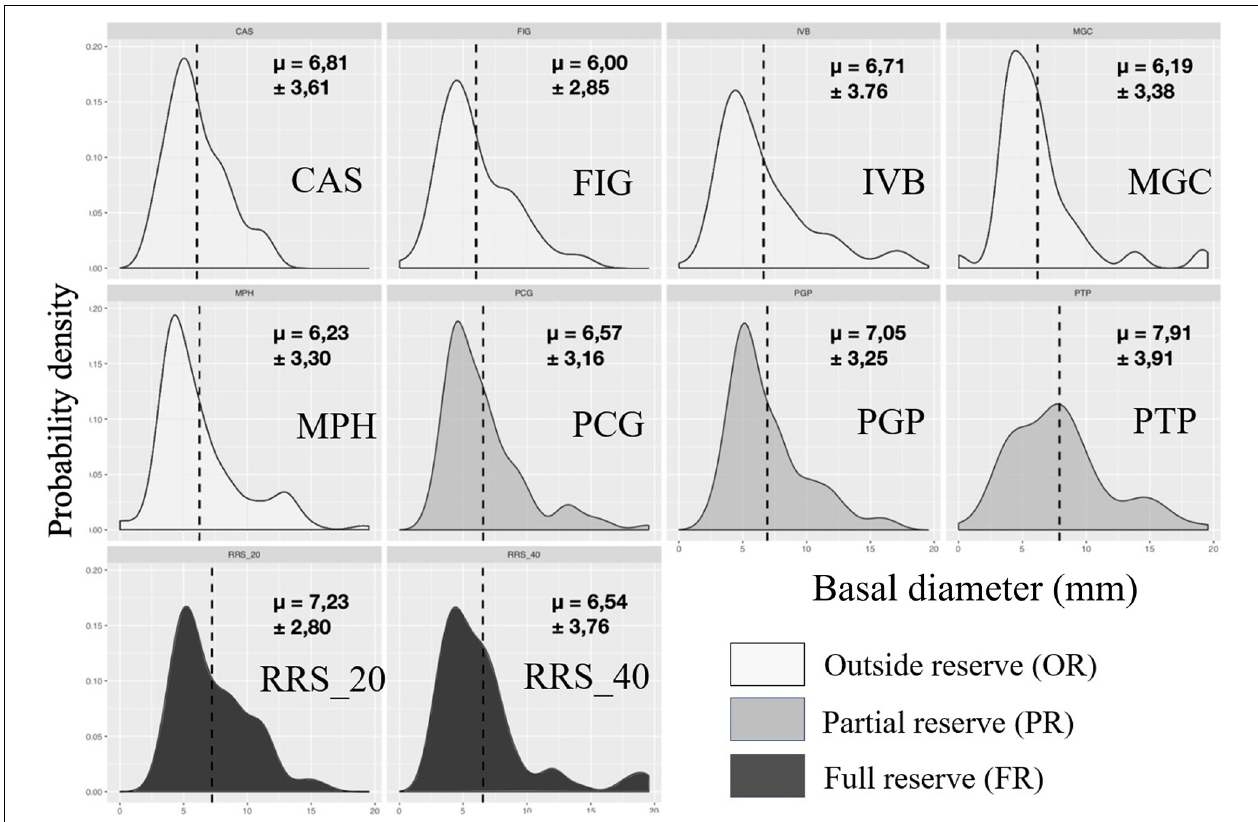
FIGURE 6 | Calanques national park: representation of probability density functions by population of each site for basal diameter (mm) in 2020. The values indicated correspond to the means followed by the standard deviations. In dark the populations in full reserve (RRS_20; RRS_40), in medium the populations in partial reserve (PTP, PGP, PTP), in clear the populations outside the reserve (MPH, CAS, FIG, IVB,